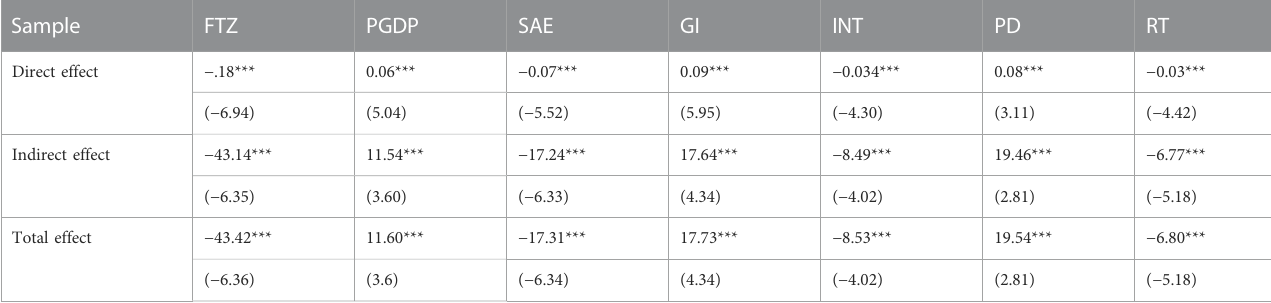
TABLE 5 Direct, indirect, and total effects of SDM-DID in column (2) in Table 4.